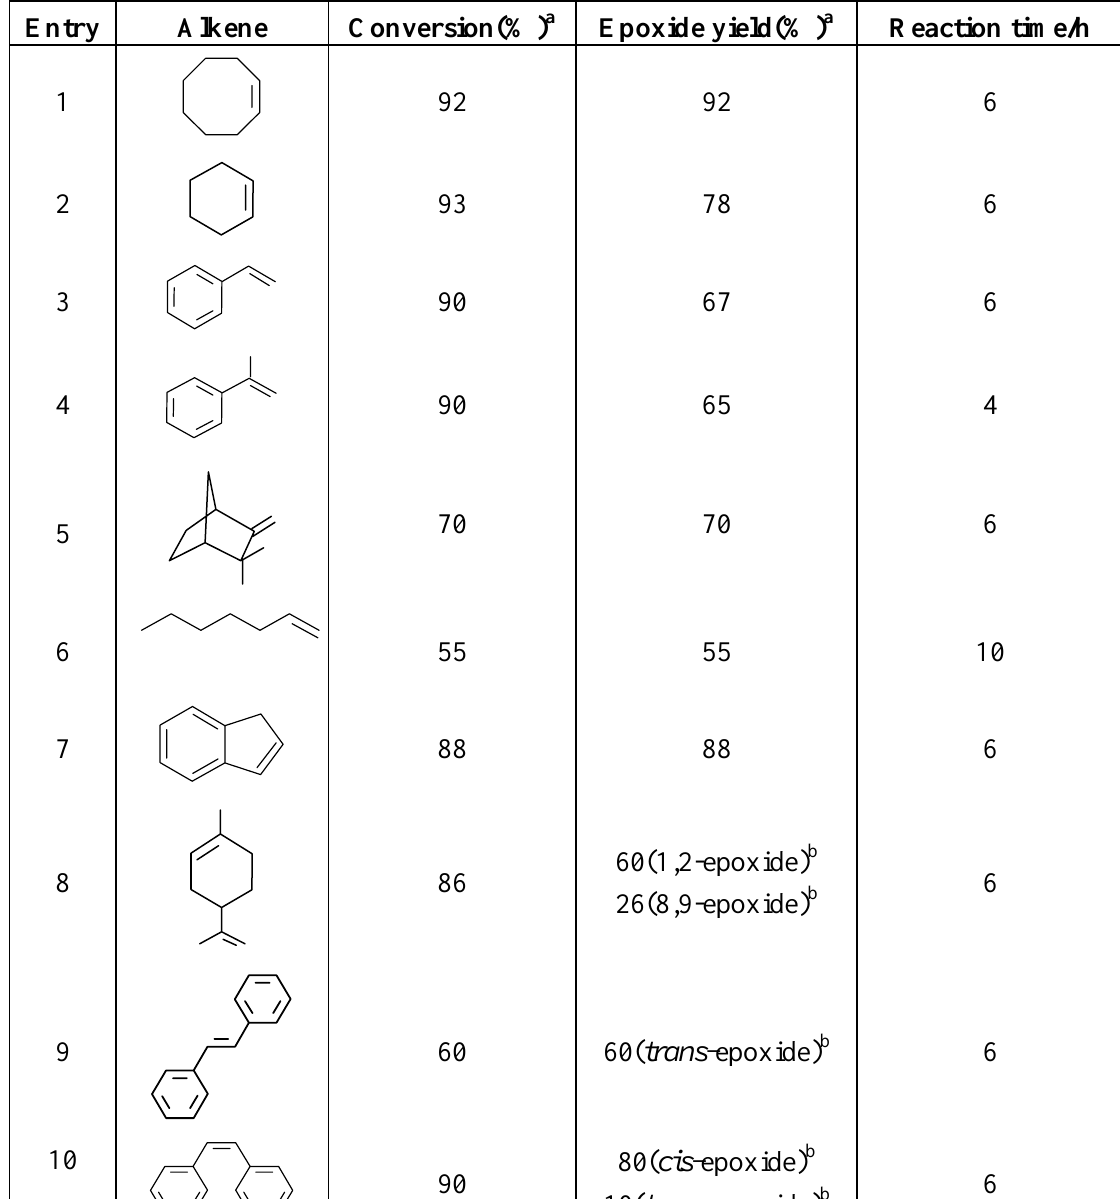
catalyzed by Mn(Br TPPS)-Ad-400 in 4 8